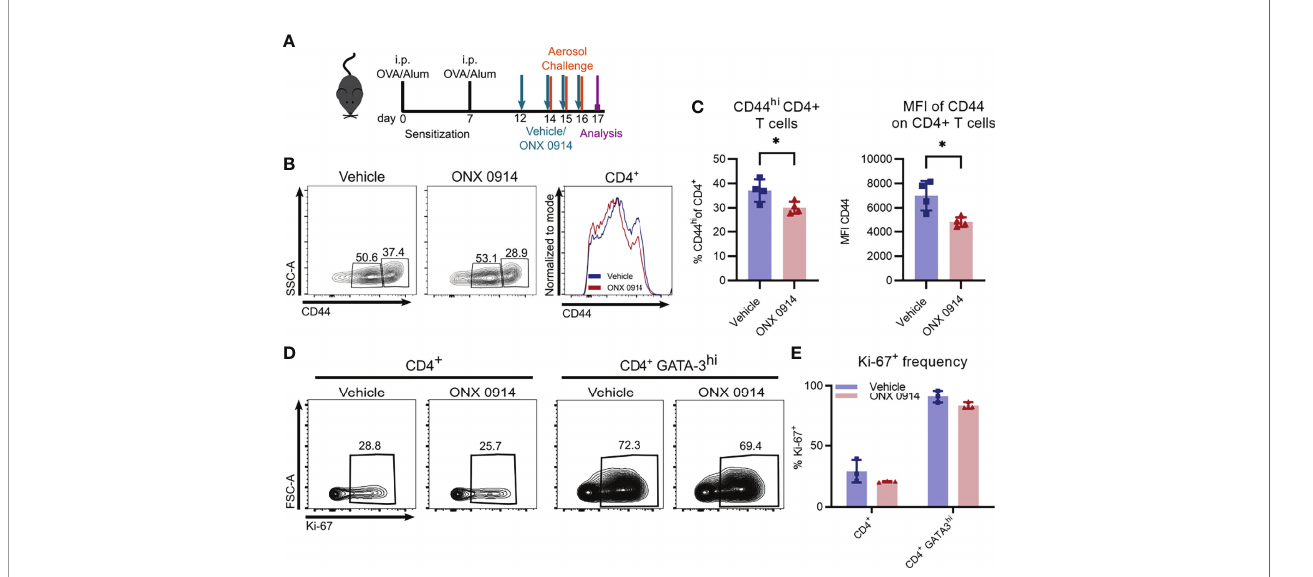
FIGURE 6 | ONX 0914 treatment reduces T cell activation but does not affect the frequency of proliferating cells. GATIR mice were sensitized with OVA/Alum by two intraperitoneal (i.p.) injections on day 0 and 7. On day 14, 15 and 16 they were challenged with aerosolized OVA for 20 min. Mice received subcutaneous injections of 10 mg/kg ONX 0914 or vehicle on day 12, 14, 15 and 16 and were analyzed on day 17. (A) Experimental setup. CD44 was analyzed on CD4 + T cells in the spleen. Gating (B) and frequency (C) of CD44 + populations of CD4 + T cells in the spleen as well as mean fl uorescence intensity (MFI) of CD44 + on CD4 + T cells (right) (n=4). (D) Gating of Ki-67 positive populations among all CD4 + T cells (left) and CD4 + GATA-3 hi cells (right) in the lung. (E) Quanti fi cation of the respective frequency (n=3). Data is shown as mean ± SD as a representative from 2 independent experiments. Signi fi cance of differences was analyzed by two-tailed t test (C) and two-way ANOVA (E) . *p <